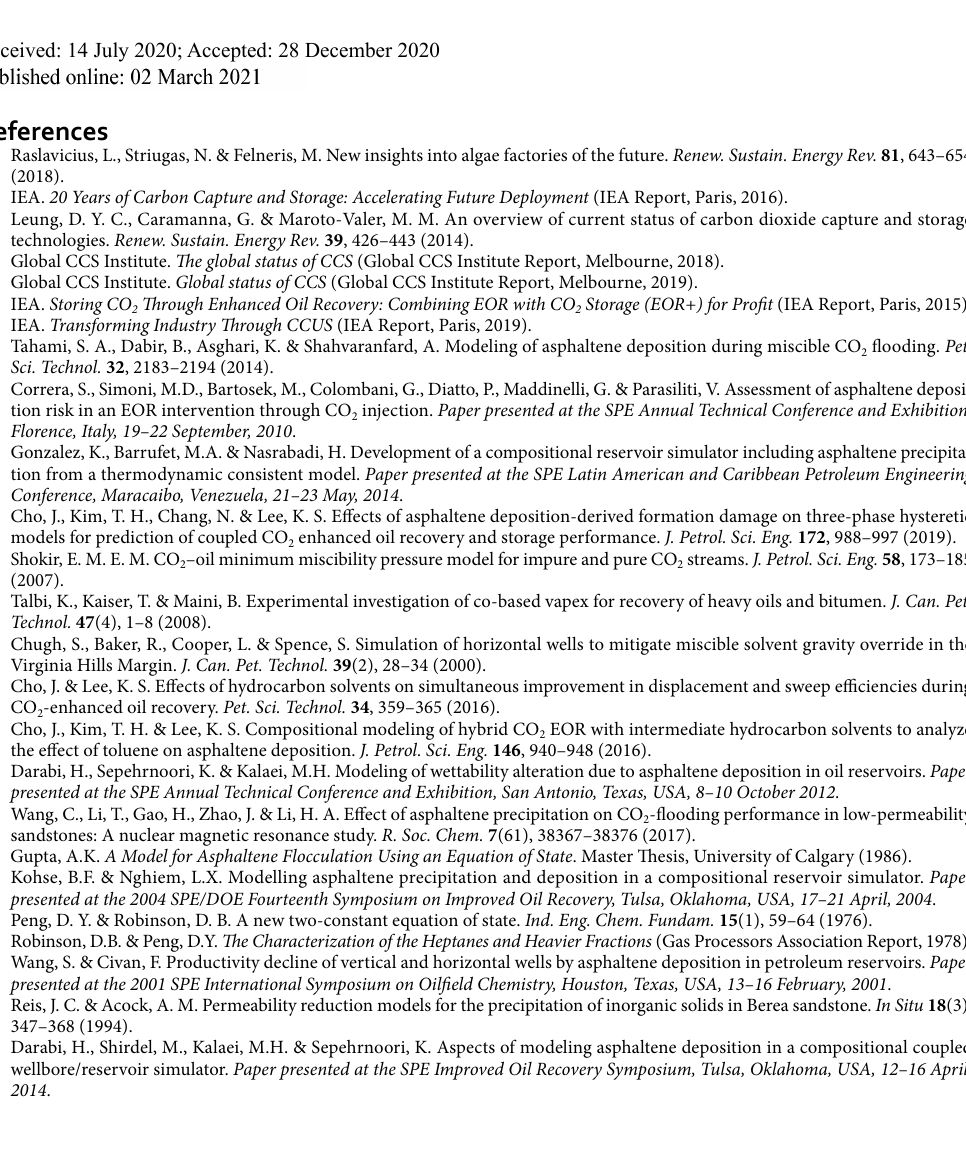
Figure 18. Oil recovery during CO 2 -LPG WAG injection in integrative models with different WAG